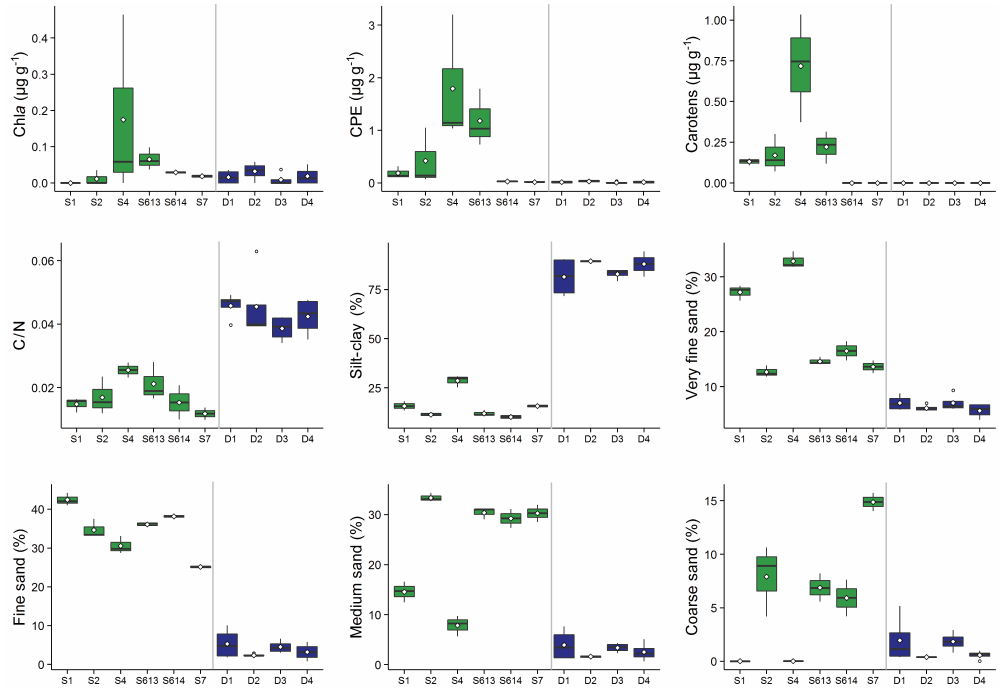
Figure 2. Environmental variables used in this study per station: Chl a (chlorophyll a ), CPE (chloroplastic pigment equivalent), carotenes, SED (sediment diversity), silt clay, very fine sand, fine sand, medium sand, and coarse sand. Green box plots represent shallow stations and blue box plots represent deep stations. Black lines represent the median, empty circles represent the mean, lower box indicates the first quartile, and upper box the third quartile. Upper line shows the maximum value and lower line the minimum